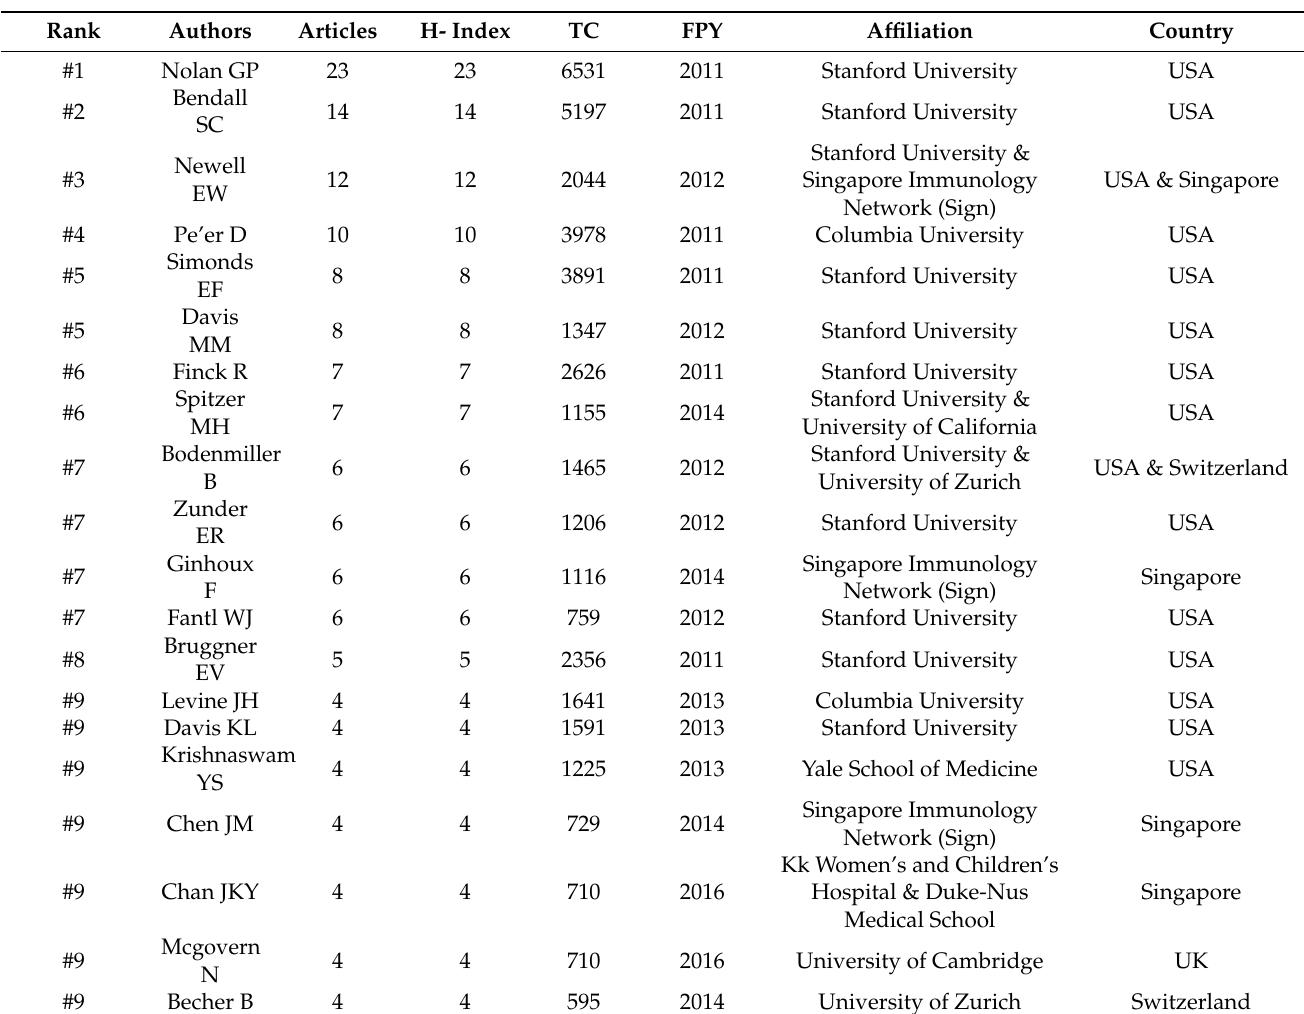
Table 3 highlights the 20 most relevant authors in mass cytometry according to the number of published HCPs. Nolan GP ranked highest with 23 HCPs followed by Bendall SC (14 HCPs) and Newell EW (12 HCPs). Nolan GP was also one of the authors with the earliest date of first publication and the highest number of total citations (6531). The affiliations of these authors (75%) corresponded mainly to American hospitals, research centers, and universities. Table 3. Top 20 most relevant authors and their impact (H-index and TC) in the field of mass cytometry.